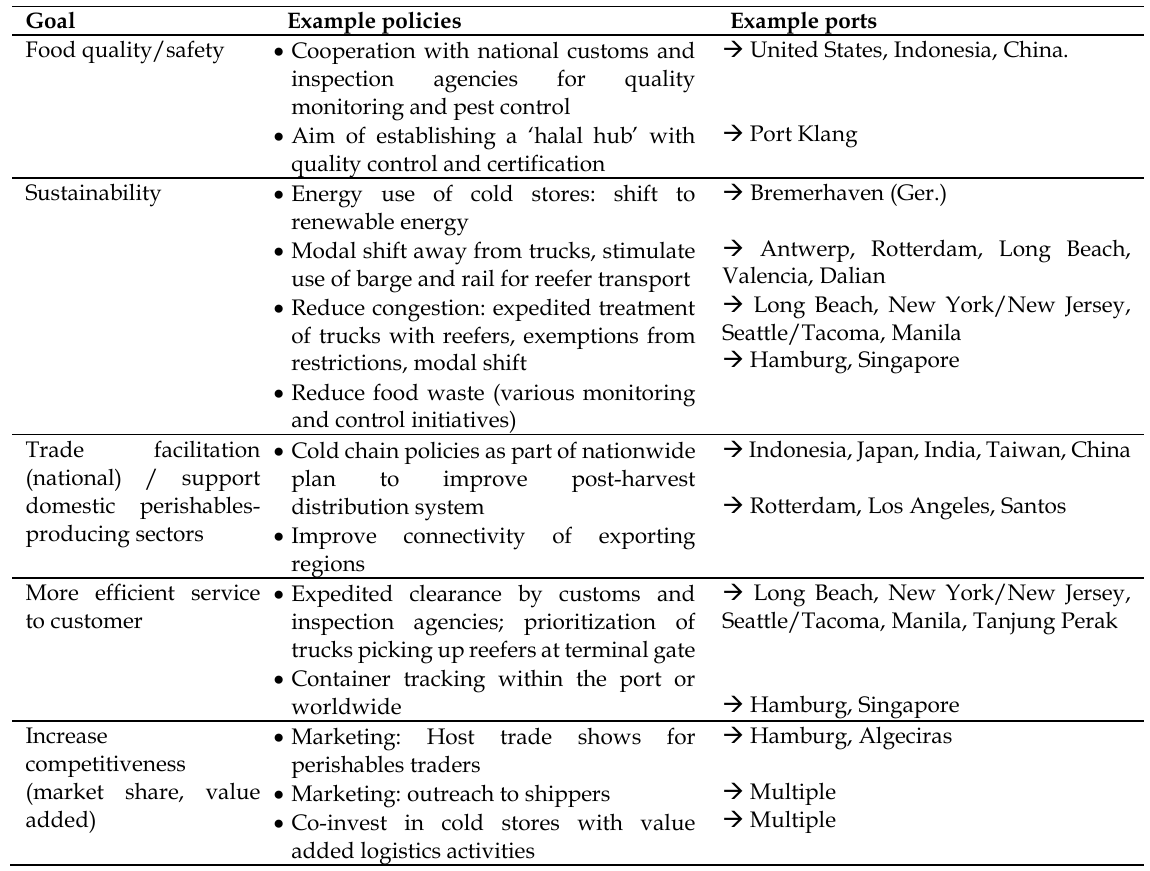
Possible goals of reefer-related policies and examples of ports reporting a